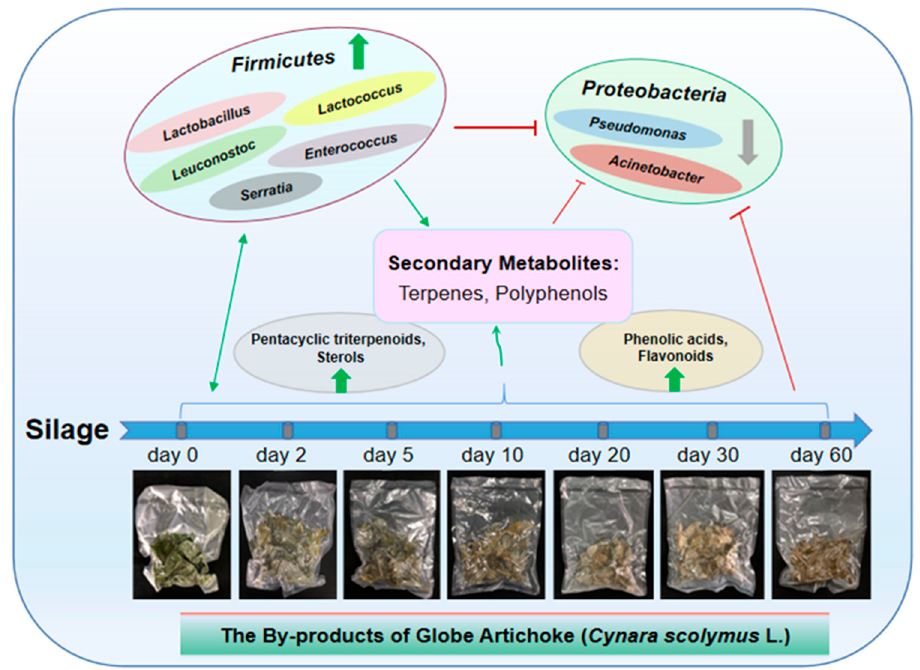
Figure 7. Proposed model depicting the effects of silage on polyphenols and terpenes in globe artichoke ( Cynara scolymus L.) by-products, involving the changes in the structures of microbial communities. Thick arrow stands for a promotion or inhibition effect, “ → ” stands for a promotion effect, “ t ” stands for an inhibition effect.